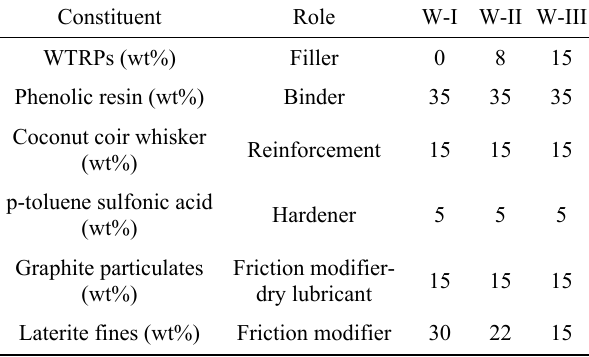
Table 1 Constituents of the different